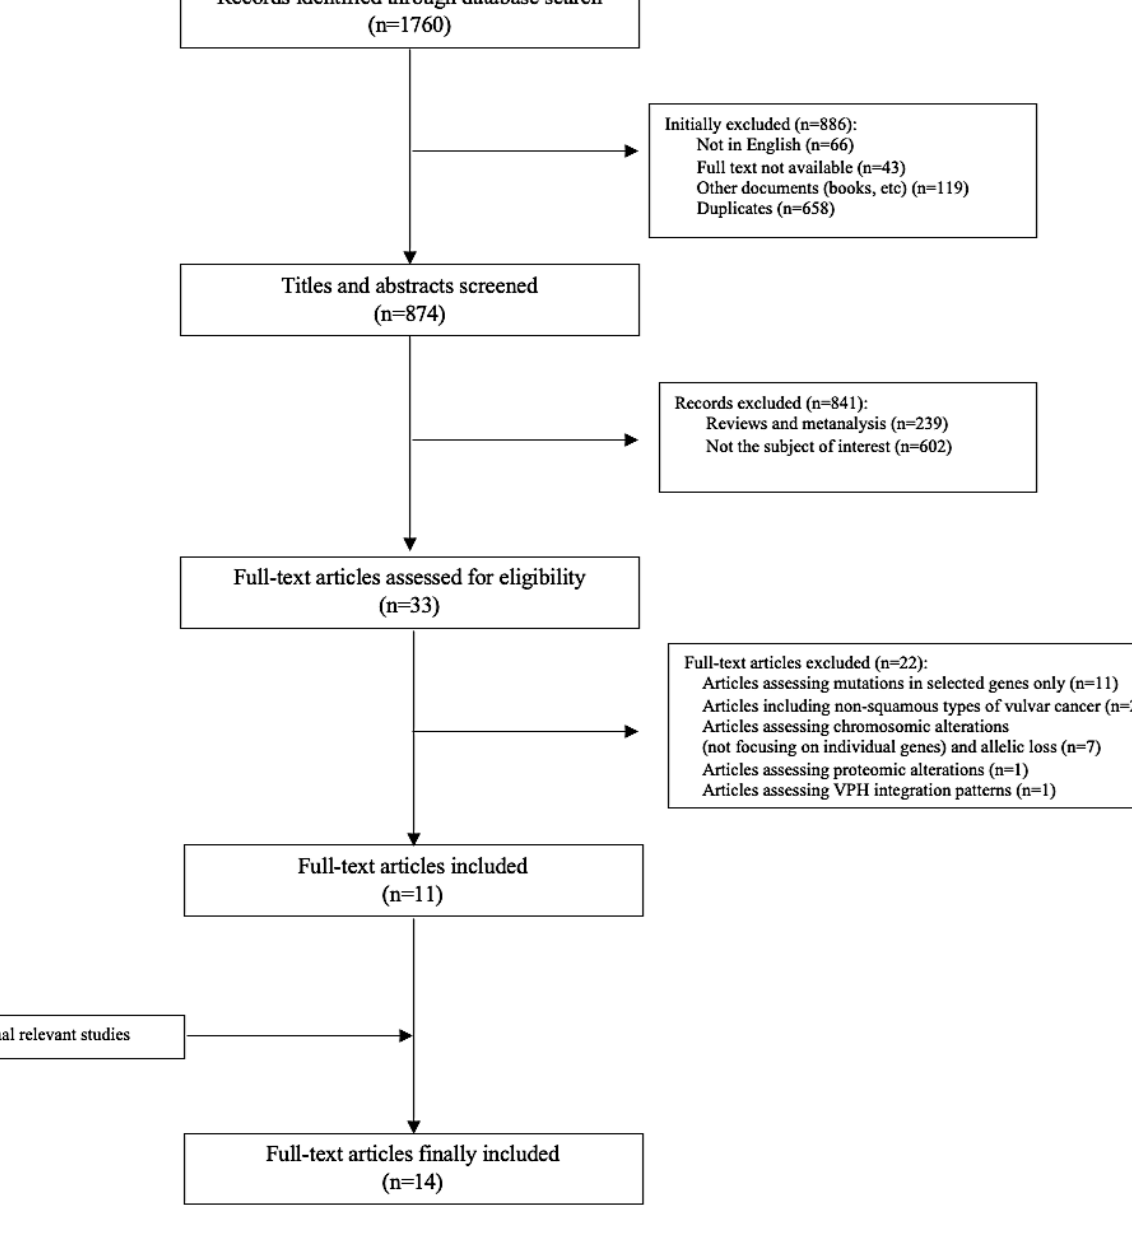
Figure 1. Flow diagram of publication screening and